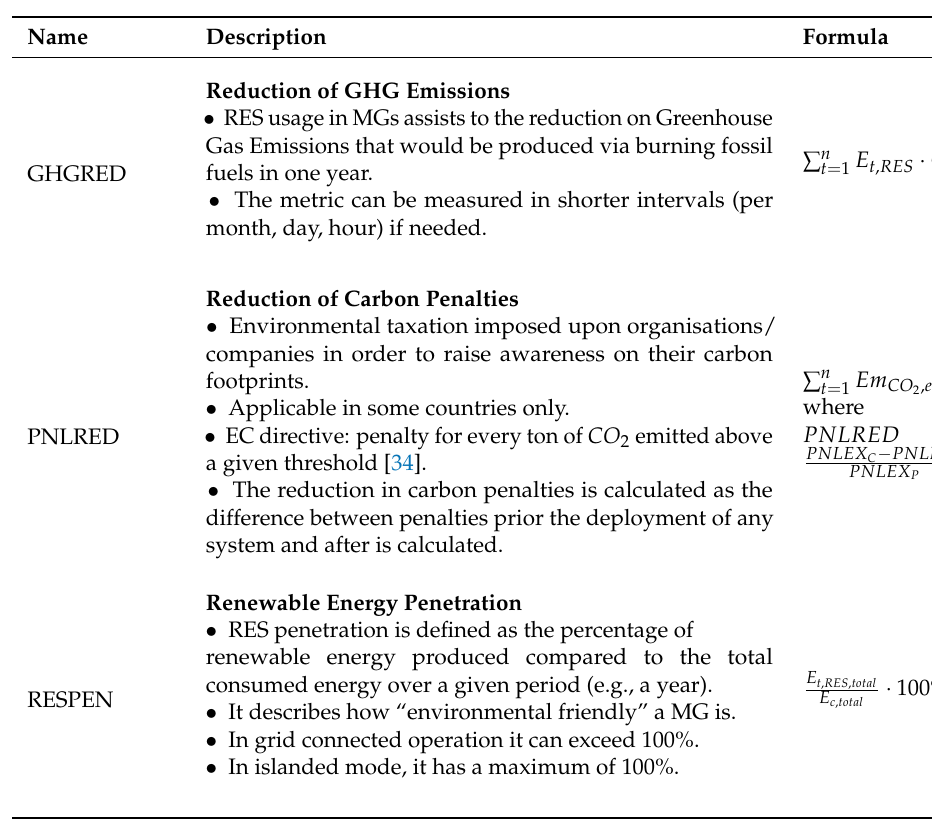
Table A2. Detailed Representation of MG Environmental